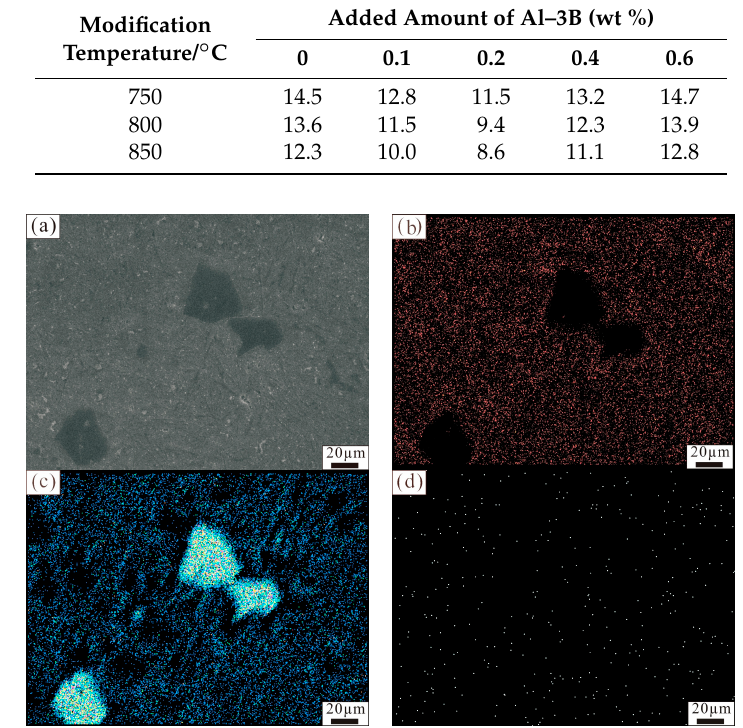
Table 2. Area fraction of primary Si in the Al–18Si modified at different temperatures with different amounts of Al–3B (%).